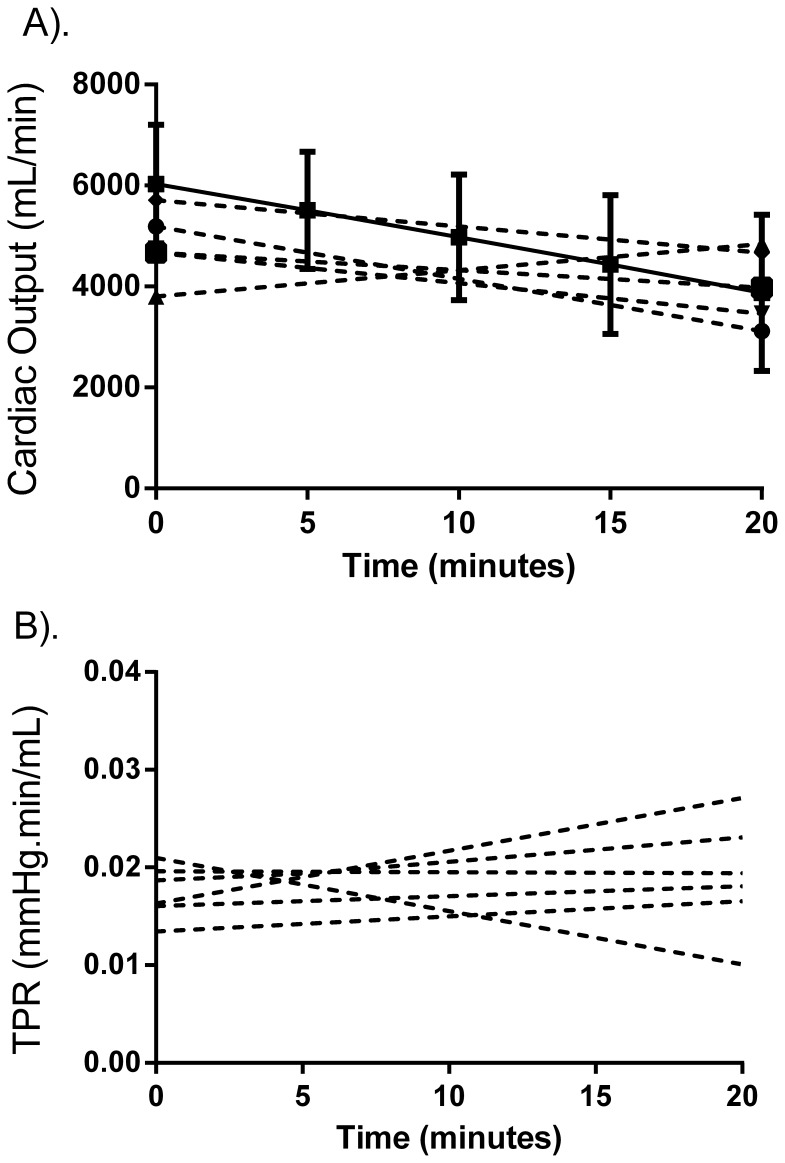
Tracking changes in CO (A) and TPR (B) during hemorrhage.The experimental data (collected at the beginning and end of the hemorrhage only) is not different from model predictions (p<0.05). The solid lines represent the mean model output, and the dotted lines are taken from Skillman’s report [5]. Error bars represent standard deviation; all experimental values are statistically similar to model output (p<0.05).